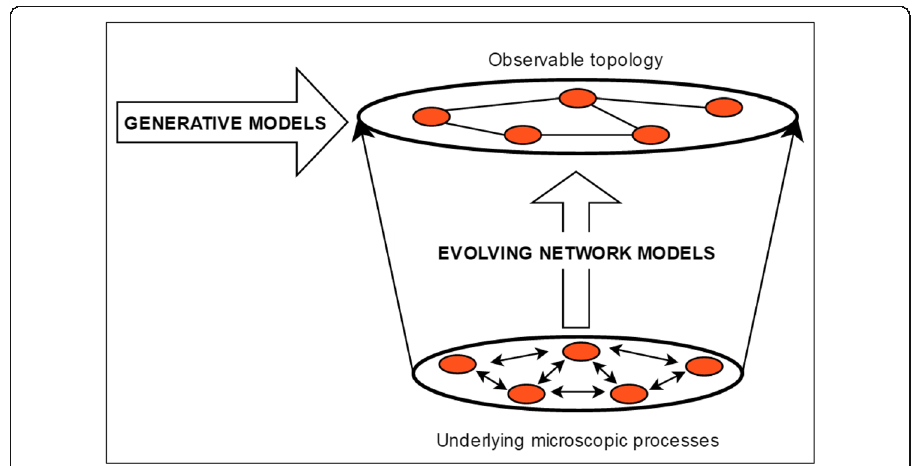
Fig. 2 Modelling Perspectives obtained from Generative and Evolving Network